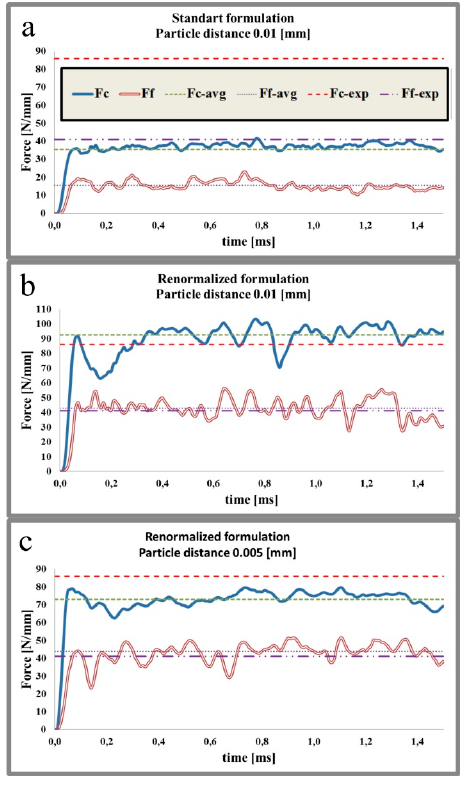
Figure 7. Cutting force F c and feed force F f versus time for h c = 0.04 mm. Metals 2019 , 9 , x FOR PEER REVIEW